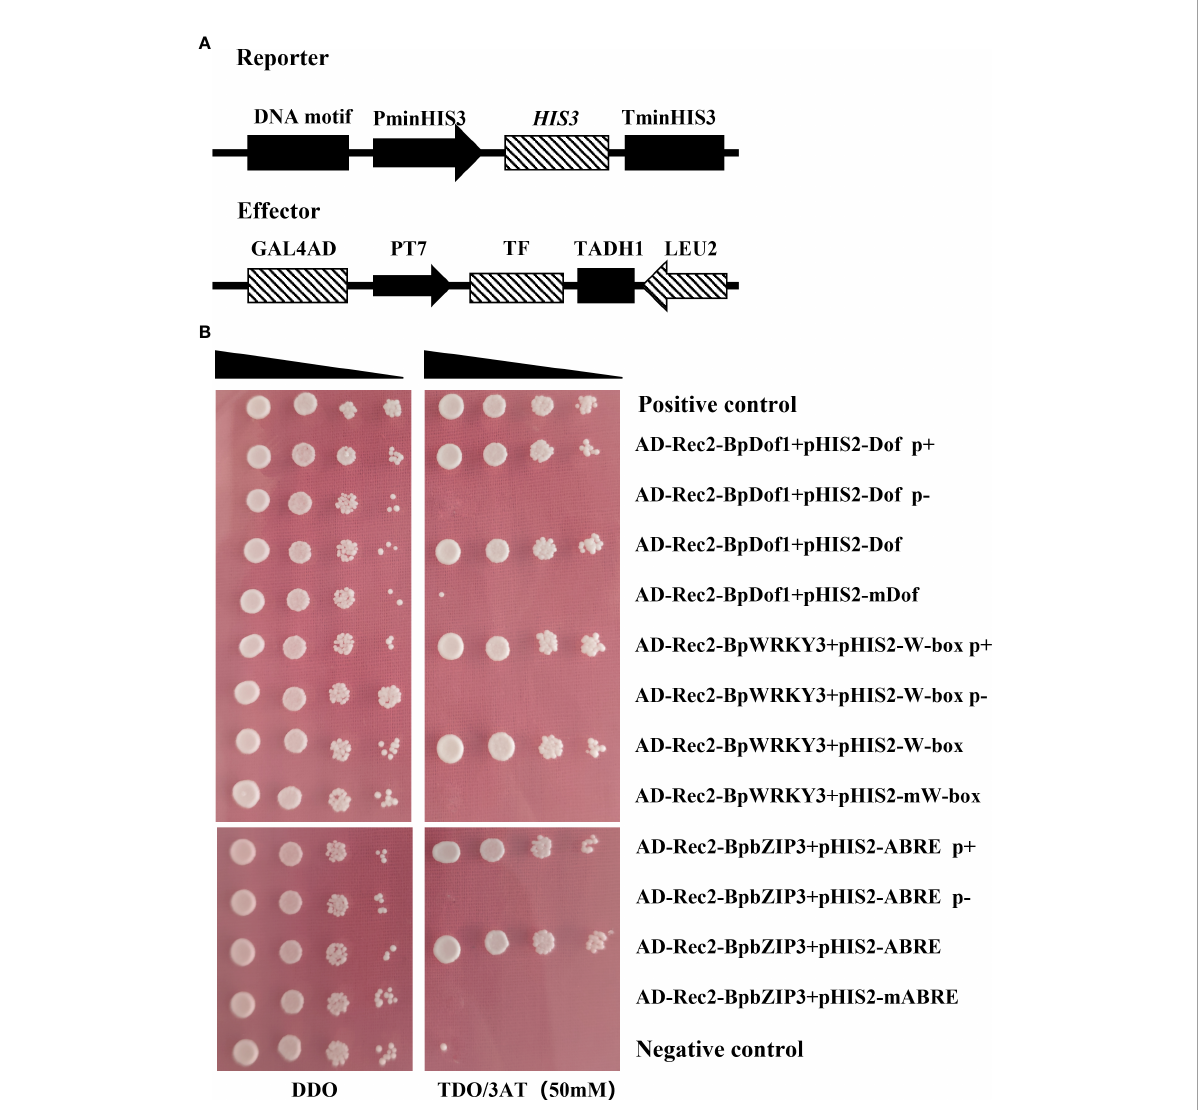
FIGURE 5 Analysis of the upstream regulatory factors that bind to the Dof, W-box, and ABRE elements by Y1H assays. (A) Schematic diagrams of the reporter and effector vectors. (B) Veri fi cation of the BpDof1, BpWRKY3, and BpbZIP3 effectors and reporter constructs of speci fi c DNA motifs co- transformed into yeast Y187 cells. The DNA motifs are as follows: Dof p+, Dof p-, Dof, and mutated Dof elements; W-box p+, W-box p-, W-box, and mutated W-box elements; ABRE p+, ABRE p-, ABRE, and mutated ABRE elements. Dof p+, W-box p+, and ABRE p+: truncated BplMYB46 promoter containing Dof, W-box, and ABRE elements, respectively (located at -794 bp – -564 bp, -1347 bp – -1149 bp, and -534 bp – -348 bp upstream of the ORF of BplMYB46 , respectively). Dof p-, W-box p-, and ABRE p-: truncated BplMYB46 promoter lacking Dof, W-box, and ABRE elements, respectively (located at -706 bp – -582 bp, -1305 bp – -1149 bp, and -480 bp – -348 bp upstream of the ORF of BplMYB46 , respectively). Dof, W-box, and ABRE elements: three tandem copies of Dof, W-box, and ABRE elements, respectively. Mutated Dof, W-box, and ABRE elements: three tandem copies of mutated Dof, W-box, and ABRE elements, respectively (A/T was mutated to C, G/C was mutated to A). TF means BpDof1, BpWRKY3, and BpbZIP3 transcription factor, respectively. Positive control: pGADT7-p53/pHIS2-p53; Negative control: pGADT7-p53/ pHIS2- BplMYB46